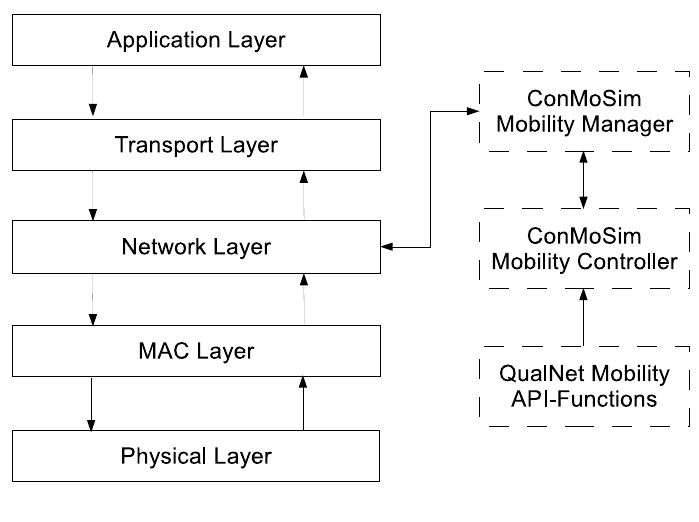
Figure 5. The structure of